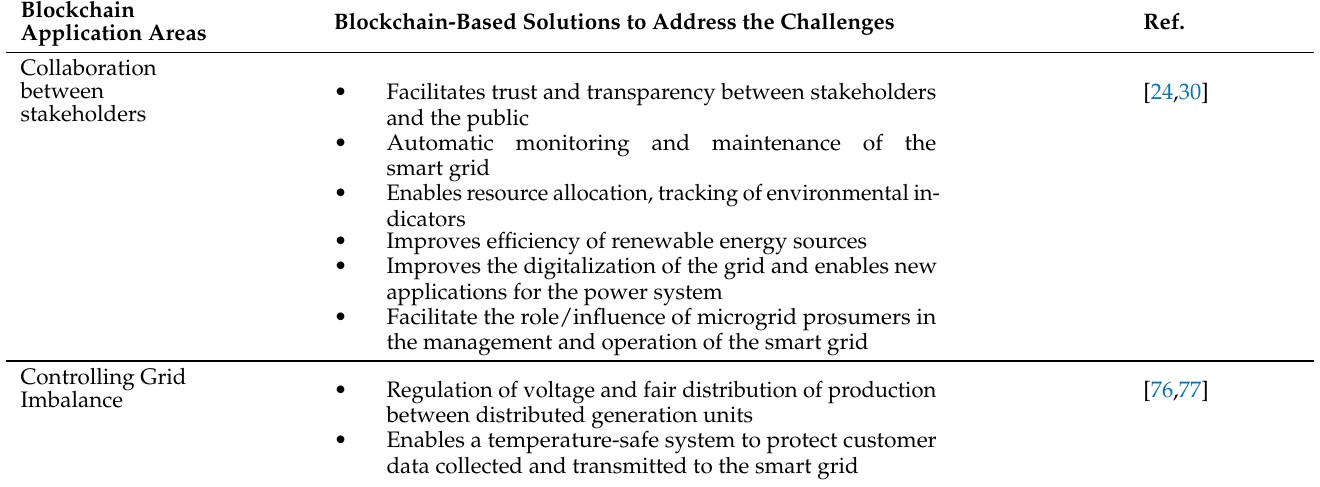
Table 5. Blockchain-based solutions to address the challenges in smart grid management, control, and